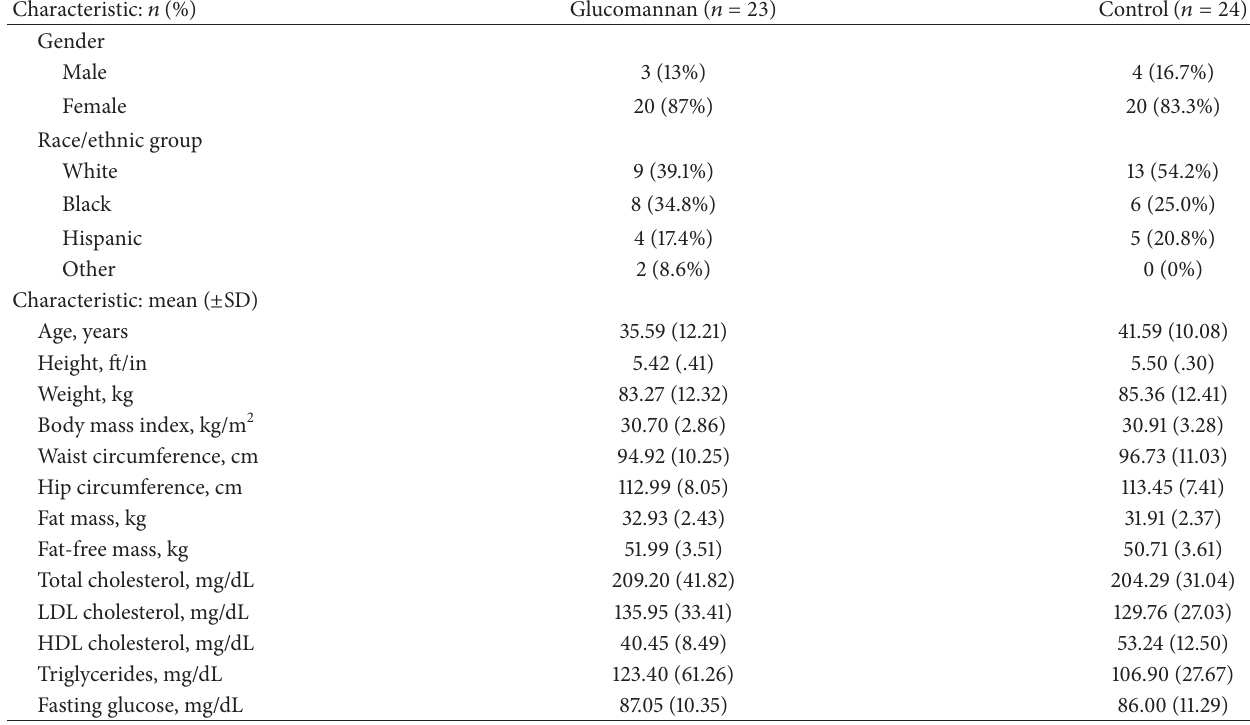
Figure 2: Study flow diagram. Table 1: Baseline demographic and clinical characteristics of study participants (𝑁 = 47)